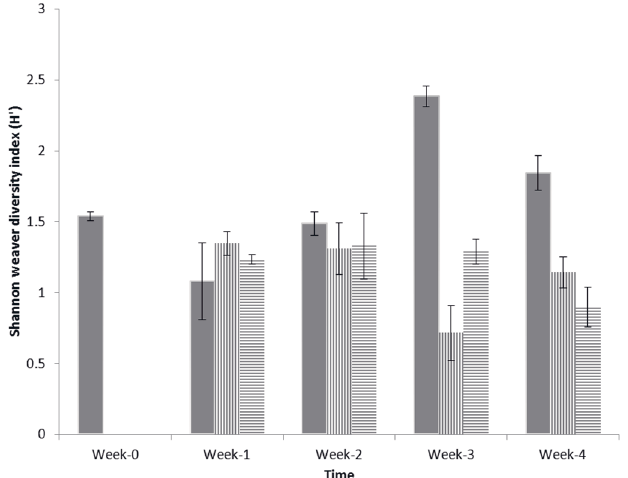
Figure 2. Diversity of three treatment samples“ ” C (seawater + BH medium + weathered crude oil + consortia); “ ” O (seawater + BH medium + weathered crude oil); and “ ” S (seawater + BH medium) from Week 0 to Week 4. Duplicate data ( n = 2) were analysed.